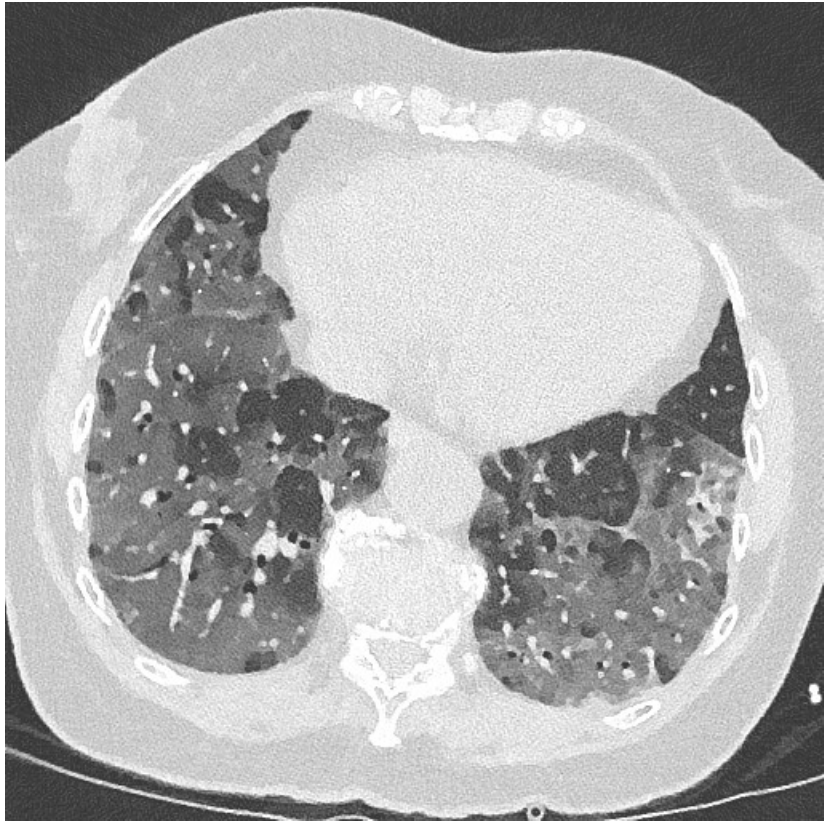
Figure 1. Low-dose chest CT showing extensive centralized and peripheral bilateral ground glass opacities with left-sided consolidations and bilateral fibrotic bands. No pleural effusion. No vascular enlargement and no specific suggestions of aspergillosis.